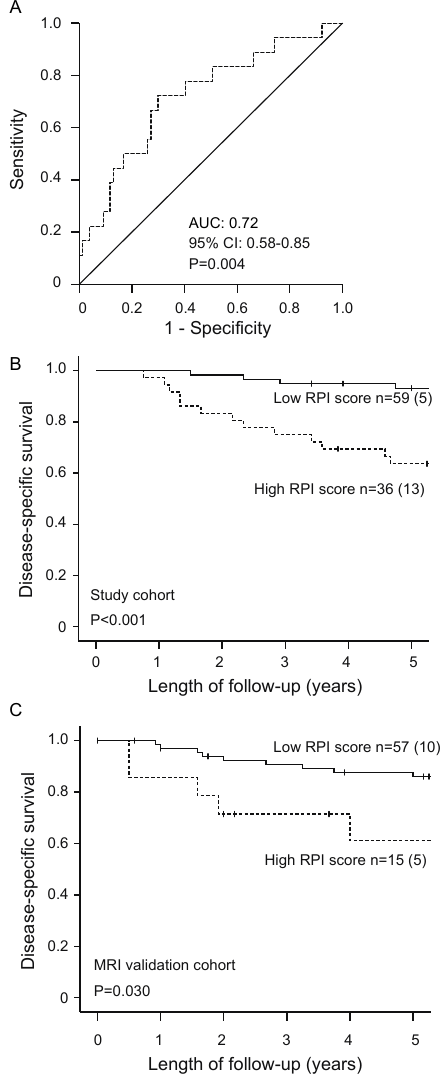
Figure 2. Receiver operating characteristic (ROC) curve for prediction of disease-specific endometrial cancer (EC) death by radiomic prognostic index (RPI) in the study cohort (n = 95; ( A )). Patients having a high RPI score had significantly reduced survival compared with patients having a low RPI score in both the study cohort (n = 95; ( B )) and the MRI validation cohort (n = 82; ( C )). For each category, number of cases/number of cases dying from EC. p- values refer to the log-rank test. AUC, area under the curve; CI, confidence